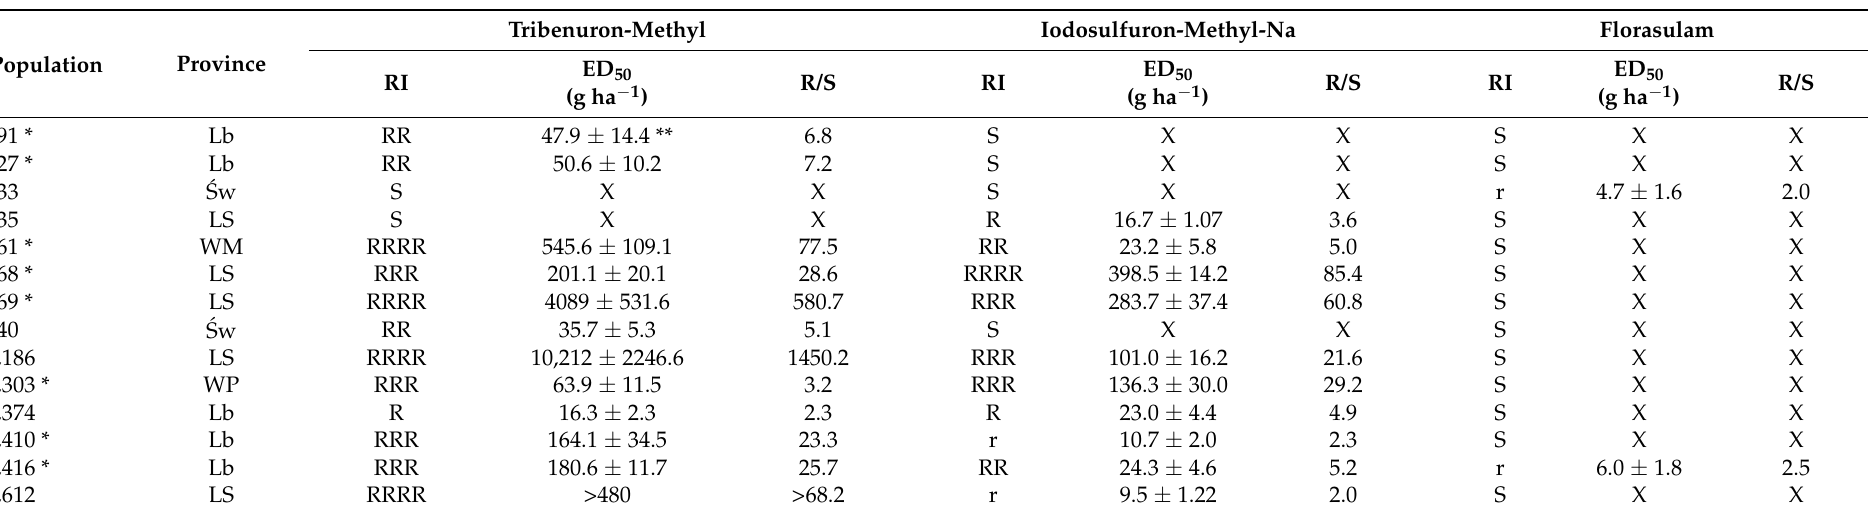
Table 2. Populations of P. rhoeas resistant to acetolactate synthase inhibitors characterised by ED 50 (effective dose causing 50% shoot fresh weight reduction in the treated plants) and resistance index